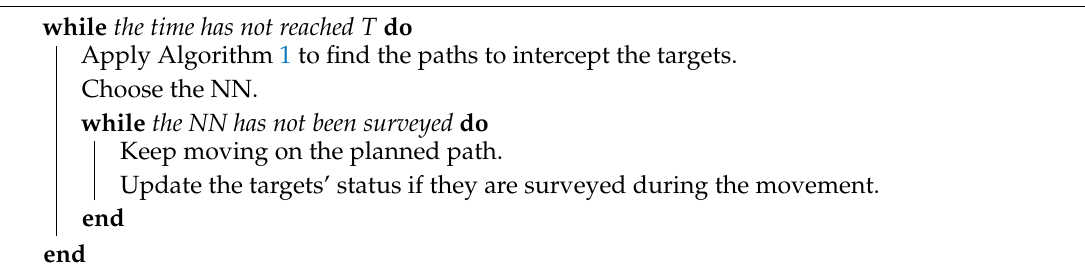
Algorithm 2: Navigating one UAV to survey multiple mobile